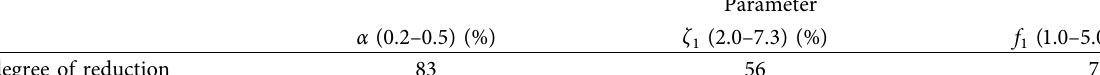
� 2.8Hz. 3 1 , and f 1 .